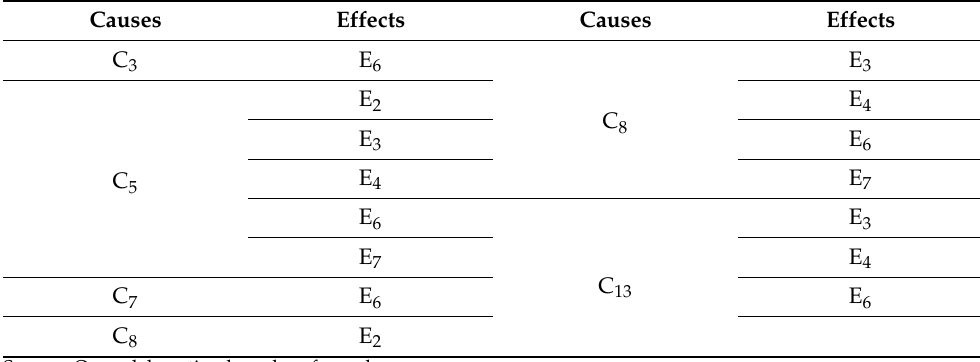
Table 12. Forgotten effects incidence